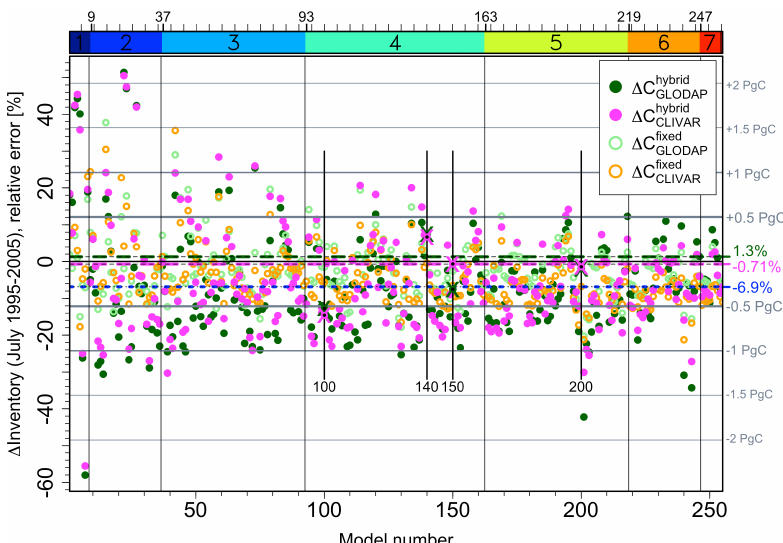
Fig. 7. Relative (left y-axis) and absolute (right y-axis) error in the change in anthropogenic carbon inventory for strategy 2 (constant model structure for all layers) between July 1995 and July 2005 for all possible 255 first order linear models. Hybrid results obtained by using combinations of regression models specific for 1995 GLODAP and 2005 CLIVAR sampling networks and projected either onto the 1995 GLODAP or the 2005 CLIVAR data ( 1C hybrid ) are shown in dark green and magenta. Parallel results obtained by using combinations of X models specific for each sampling networks when holding the observational networks fixed in time and projected onto the 1995 GLODAP or the 2005 CLIVAR data ( 1C fixed ) are shown in light green and orange. Model size is indicated by the color strip on top. Mapping errors X calculated from the “true” values are show as the horizontal dashed green (1.3%, GLODAP) and magenta ( − 0.71%, CLIVAR) lines. The dotted horizontal blue line ( − 6.9%) shows the relative error when calculating the inventory change between 2005 and 1995 using the contemporary carbon fields, without removing natural